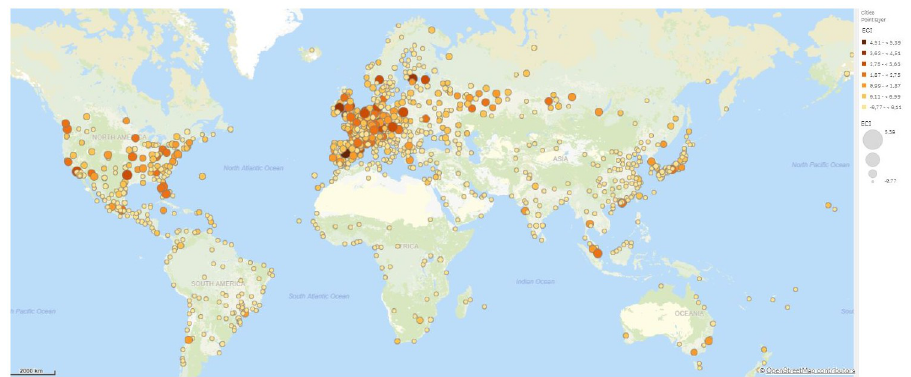
Fig 3. Cities economic complexity index (ECI) across the largest cities. Cities depicted in dark orange and big circle have a high ECI value (Data for 2010). The figure has been generated using Qlik Sense. © OpenSTreetMap contributors.